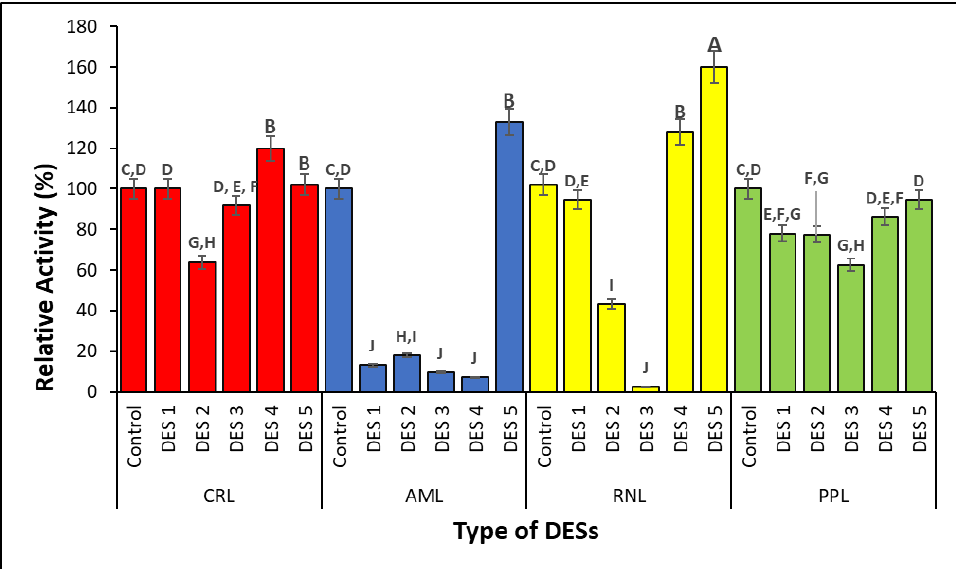
Figure 3. Lipases’ activity in the presence of hydrophobic DESs. CRL = Candida rugosa lipase, ≥ 700 U mg − 1 solid, AML = Amano lipase PS, from Burkholderia cepacian , ≥ 30,000 U g − 1 ), RNL = Rhizopus niveus lipase, ≥ 1.5 U mg − 1 ), and PPL = porcine pancreas lipase, 100 – 500 U mg − 1 protein. Means with different superscript alphabets differ considerably ( p < 0.05).